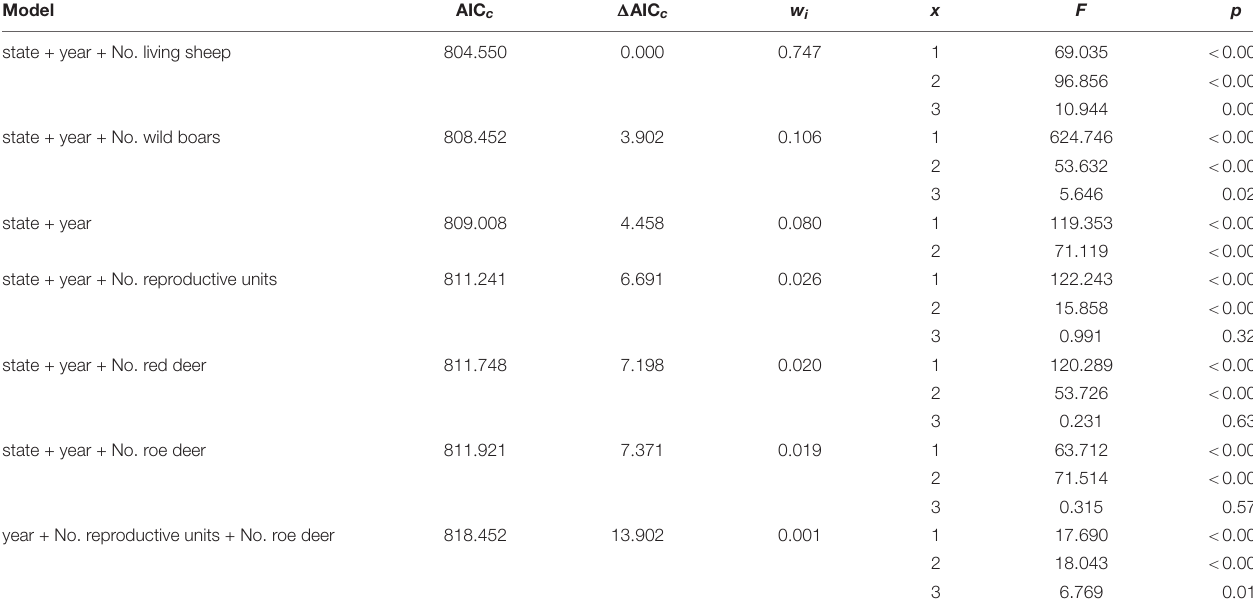
TABLE 1 | The set of the best model ( (cid:49) AIC c < 2) and six low-ranked models of the number of sheep killed by wolves ( Canis lupus ) in Germany in 2002–2019, which altogether attain the cumulative model weight of 1. Model AIC